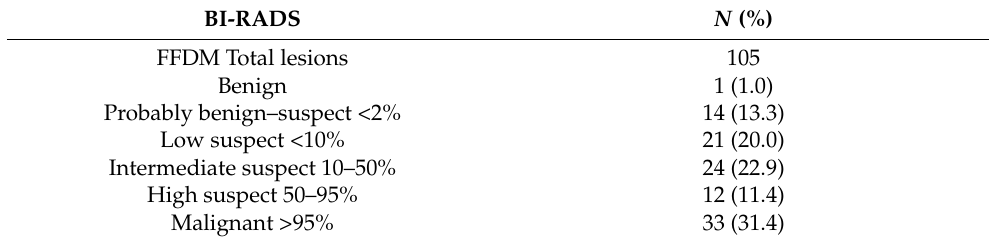
Figure 2. Local advanced breast cancer of the left breast. FFDM ( a ) does not allow for detection of the real disease extension of the lesion, in relation to breast density. MRI ( b ) and CESM ( c ) show multiple foci in relation to multicentric disease. Table 3. Characteristics of the breast lesions by diagnostic test in 118 study